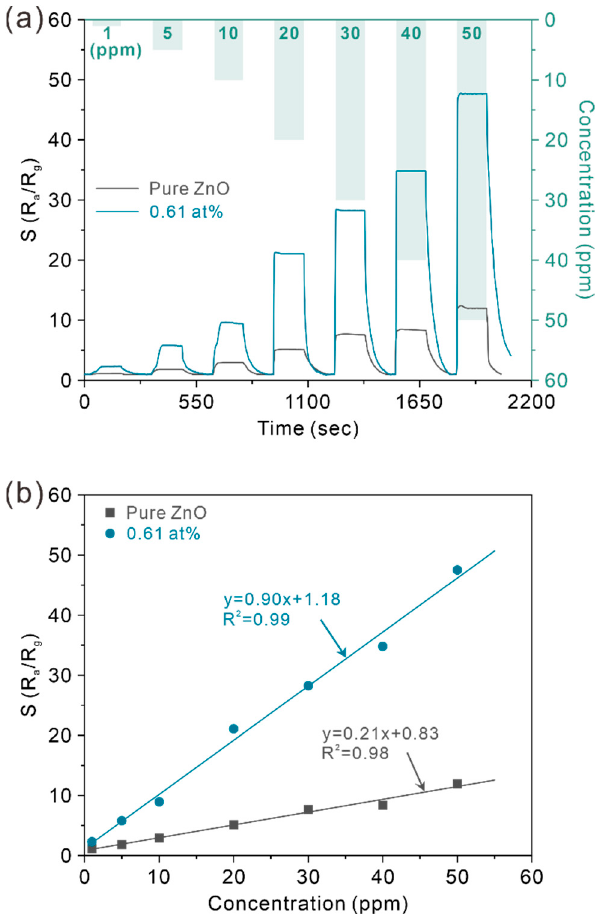
Figure 6. ( a ) The real-time response curves of pure ZnO porous nanobelts and 0.61 at% Pb-doped ZnO porous nanobelts toward different concentrations of n-butanol at 300 °C, and ( b ) their linear fitting curves between the relative responses and concentrations of n-butanol.